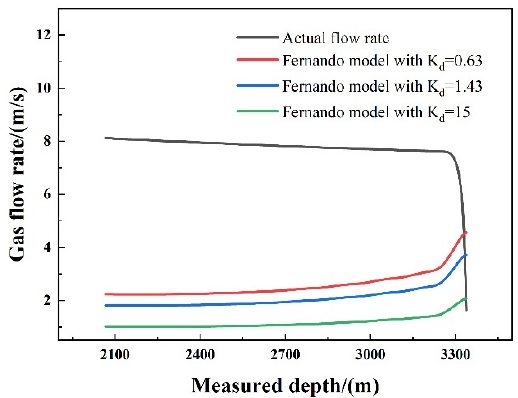
Figure 6. Verification of model applicability.